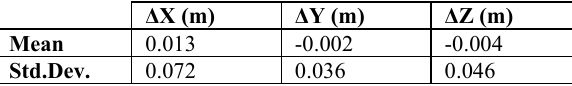
Table 8 Comparison between the coordinates of the 92 camera centre (flight 2) estimated with the standard processing (11 GCP) and the coordinates of the same camera position estimated in the NRTK processing (no